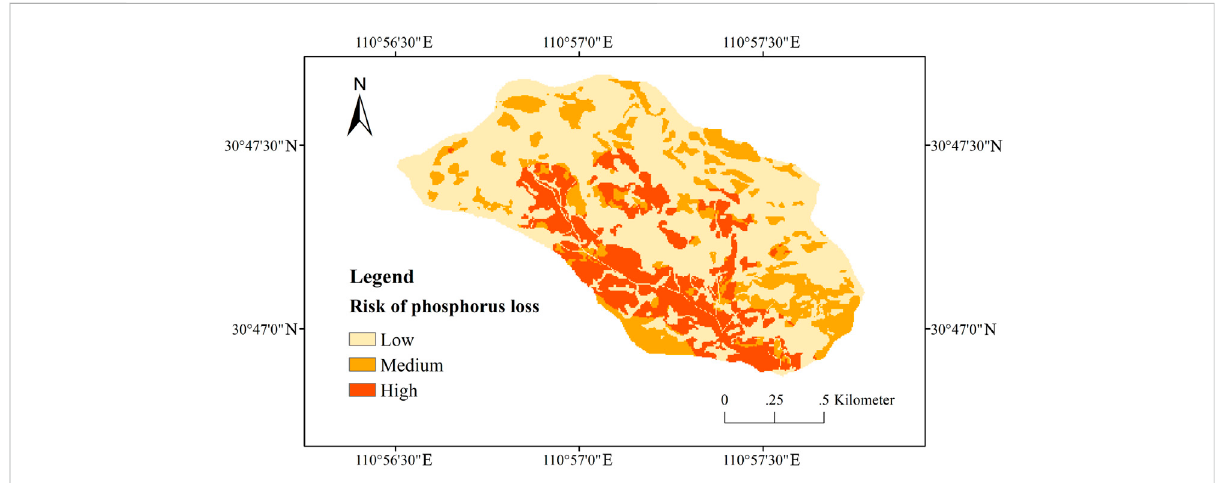
FIGURE 4 High, medium, and low potential phosphorus producing areaS in Zhangjiachong